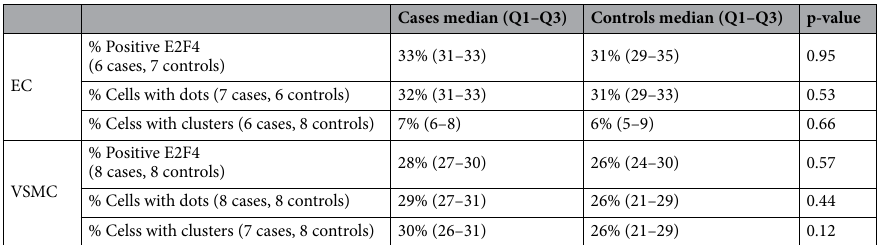
Table 4. Statistical summary of the in situ hybridization. For endothelial cells and VSMC positive cells, there are: (1) Proportion of positive cells with E2F4 , (2) Proportion of cells with E2F4 dots, and (3) Proportion of cells with E2F4 clusters. Samples with values below quartile 1 minus 1.5 times the interquartile range, or above quartile 3 plus 1.5 times the interquartile range, were considered outliers for that analysis and therefore removed. EC endothelial cells, VSMC vascular smooth muscle